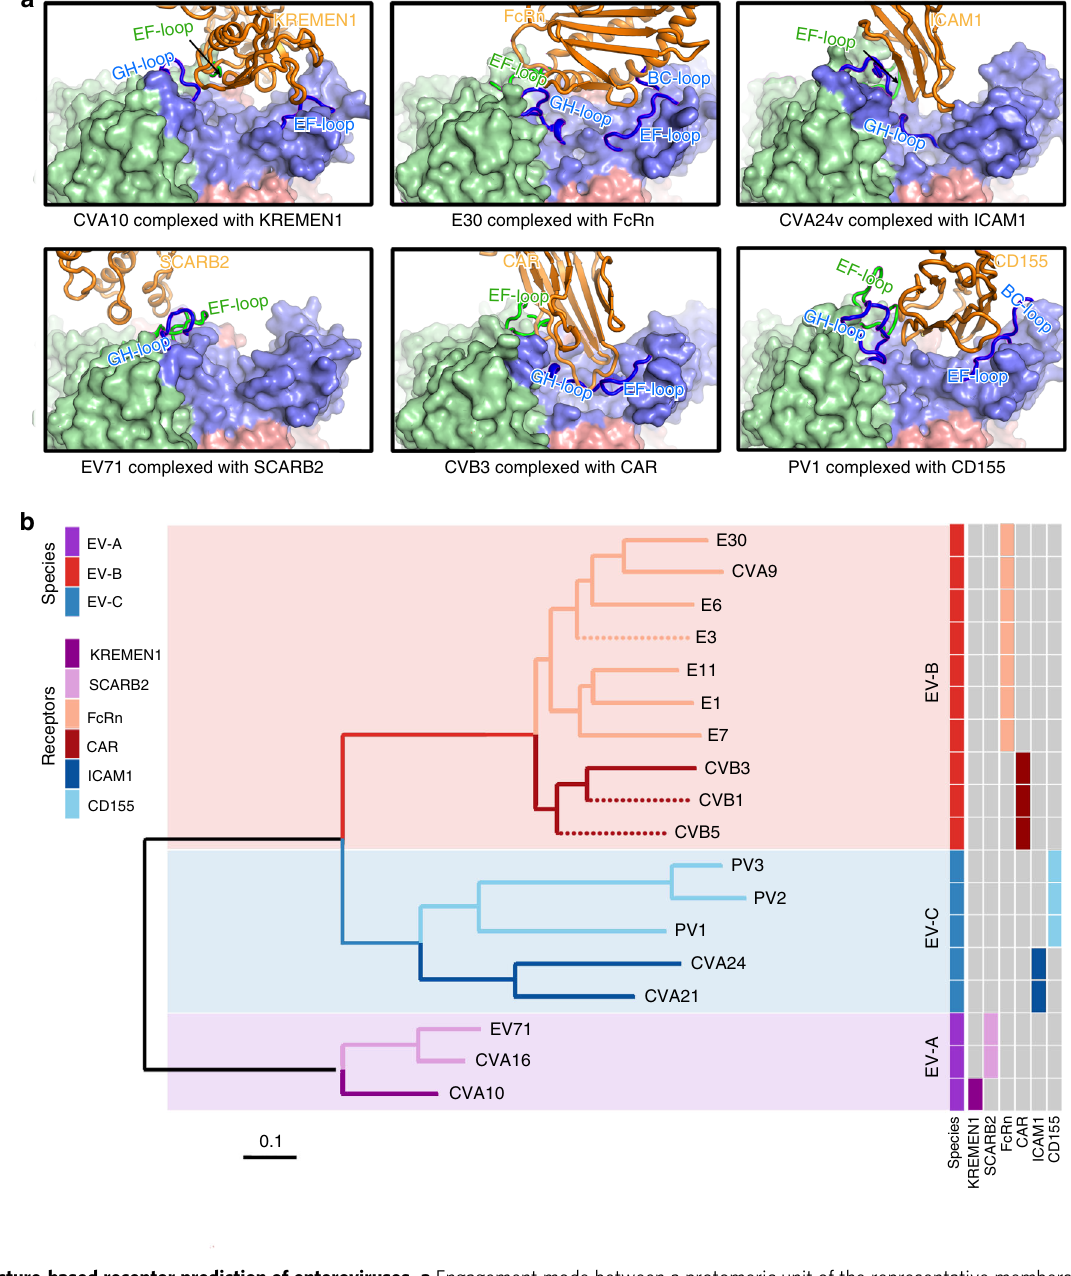
Fig. 4 Structure-based receptor prediction of enteroviruses. a Engagement mode between a protomeric unit of the representative members of species A (left), B (middle), and C (right) and its corresponding uncoating receptor. All the complexes (EV71-SCARB2, 6I2K; CB3-CAR, 1JEW; CVA24v-ICAM1, 6EIT; PV1-CD155, 3J8F) are shown from the identical perspective. The receptors are shown as cartoon in orange, while the protomers are shown as surface with loops directly interacting with their receptors shown as cartoon, accentuated in a darker color and traced in magenta (VP1 in blue, VP2 in green and VP3 in red). b Phylogenetic tree generated based on the structure-based in silico analysis of three key motifs: VP1 GH, VP2 EF, and VP1 EF loops. The dotted branches represent the new structures (pdb accession codes: 7C9X, 7C9Y, 7C9Z) that were selected for predication veri fi